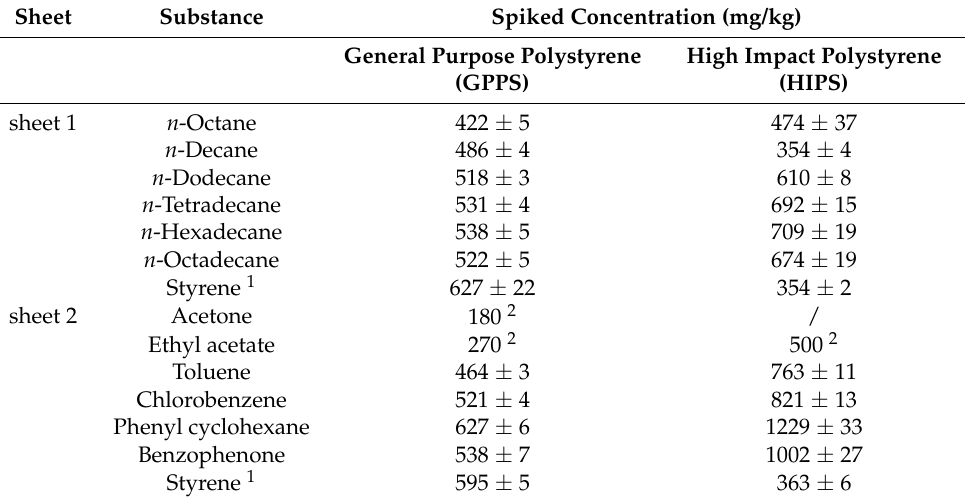
Table 1. Experimentally determined concentrations of model compounds in the spiked polystyrene (PS)